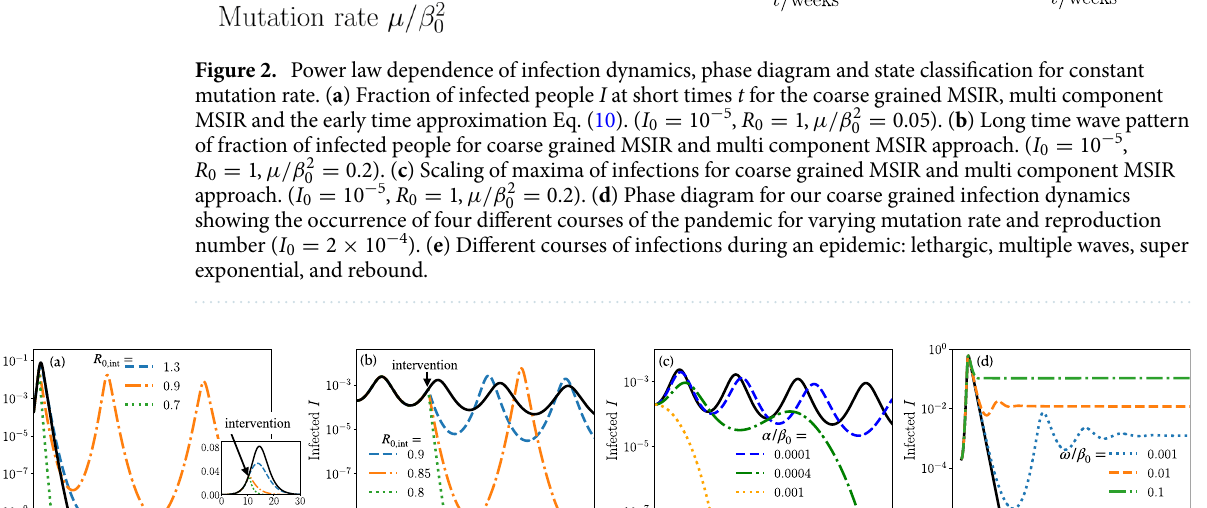
R 1.5 , µ/β 2 10.5 0.004 , t int 0 0 = = = 3 , t 1 , µ/β 2 210 10 int − 0 = = = 1 , =